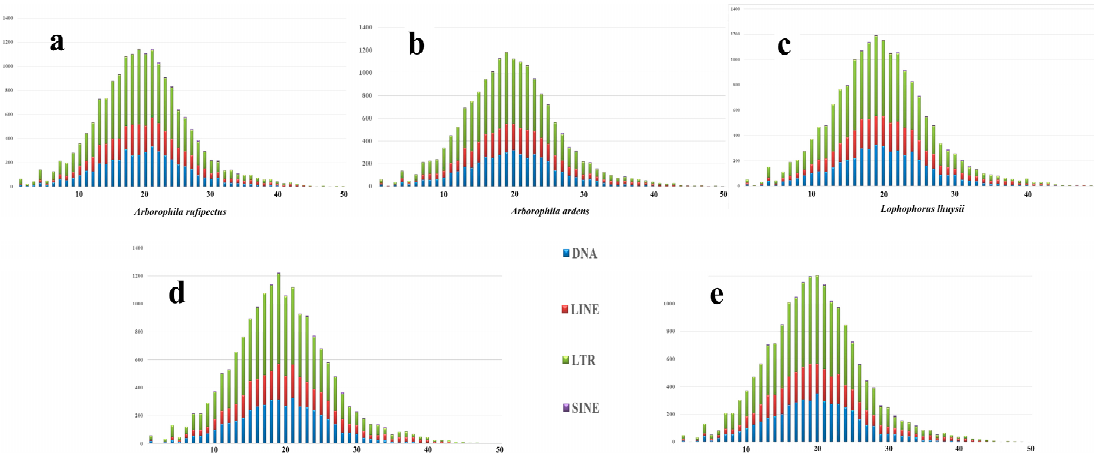
Figure 4. Divergence rate distribution of four major types of transposable elements (TEs) in ( a ) Sichuan partridge ( Arborophila rufipectus ), ( b ) Hainan partridge ( Arborophila ardens ), ( c ) Chinese monal ( Lophophorus lhuysii ), ( d ) turkey ( Meleagris gallopavo ), and ( e ) chicken ( Gallus gallus ) genomes. The divergence rate was calculated between their identified TE elements in the genome and the consensus sequences (Repbase).